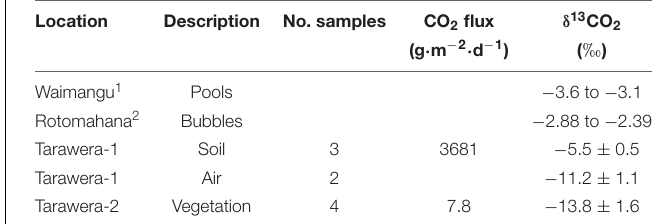
TABLE 3 | δ 13 CO 2 isotopic data.